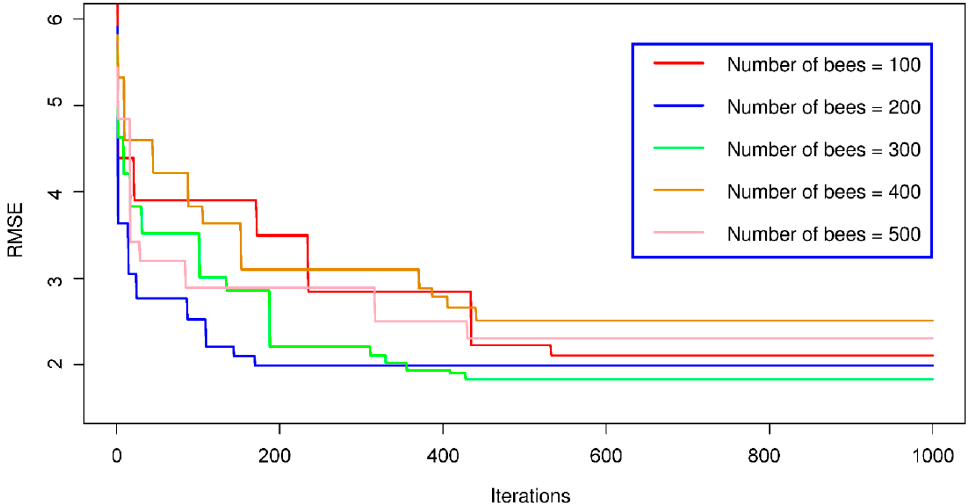
Figure 18. Artificial bee colony (ABC)-ANN performance for estimating HL of EEB systems in the training process.